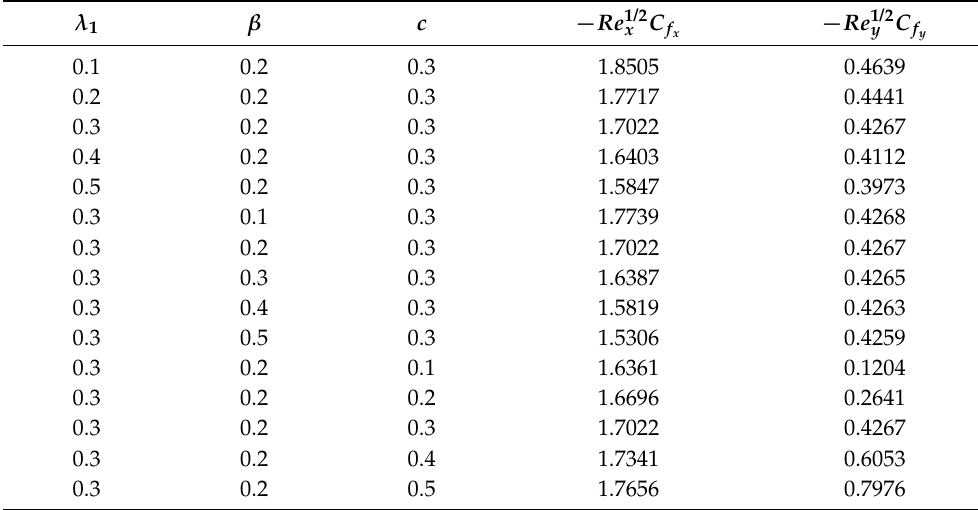
Table 2. Numerical values of the skin-friction coefficient for the fixed values α = 0.3, γ =